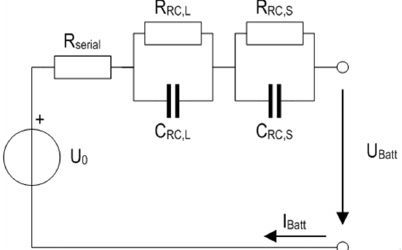
Figure 2. Battery model for the simulation. Equivalent circuit diagram to visualize the dynamic operation behavior of a li-ion battery (adapted from Chen et al. [37]). One serial resistor in the series to one RC element with long time constants (minutes range “L”) and one RC element with short time constants (seconds range “S”) according to Chen et al. [37].